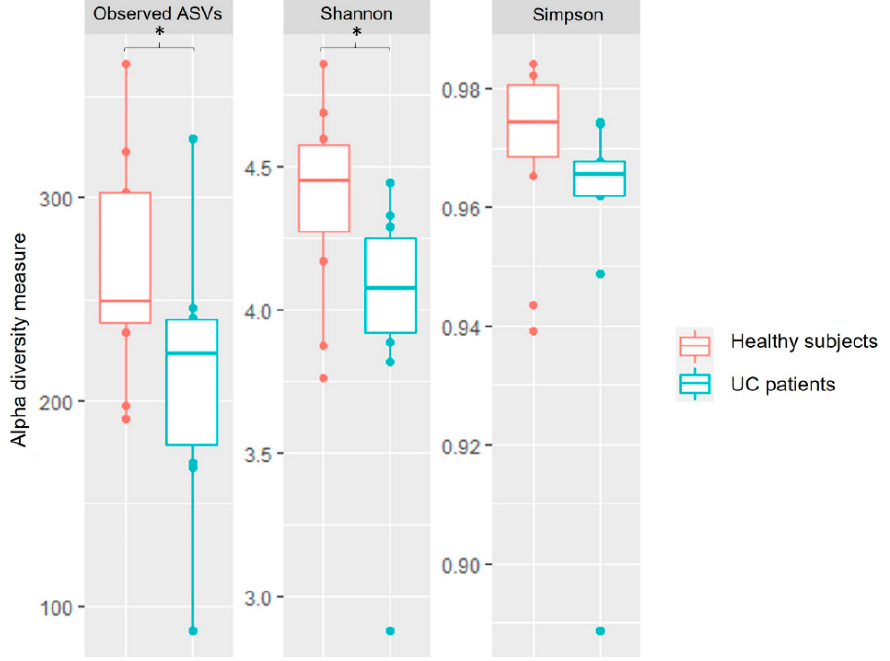
Figure 1. Boxplots representing the different alpha diversity indices (observed, Shannon, and Simpson) detected in the saliva samples of the UC patients and healthy subjects. Alpha indices that showed statistically differences (* p -value < 0.05) following the ANOVA test are marked with an asterisk.